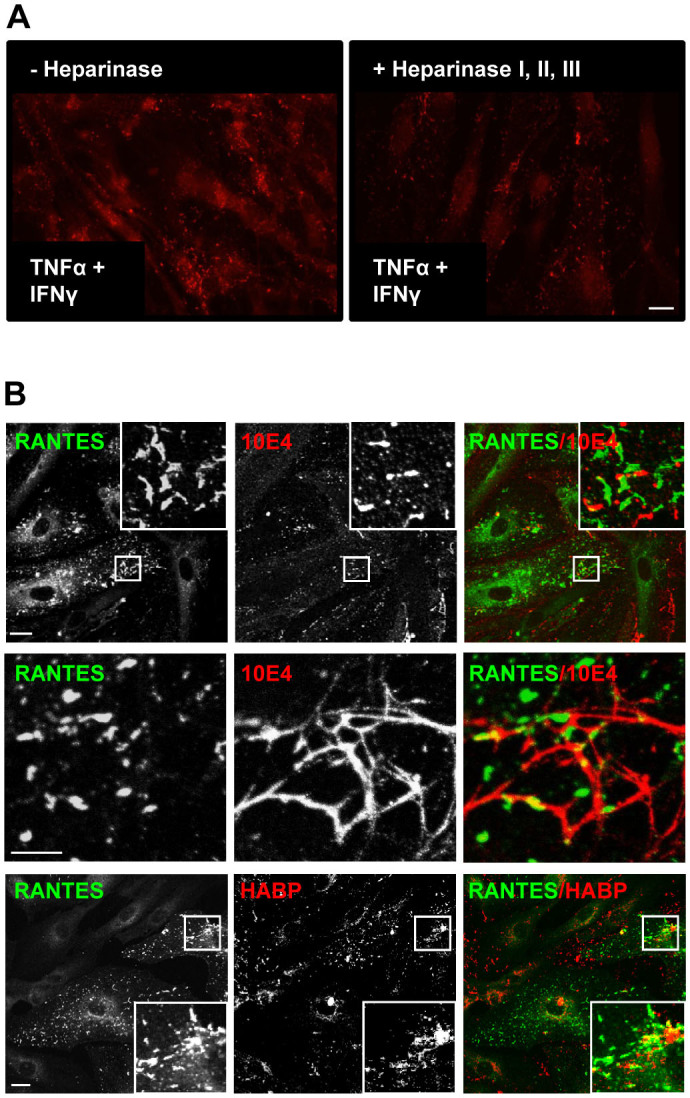
RANTES is immobilized to the cell surface via heparan sulfate.(A) HUVECs were stimulated for 48 h with 10 ng/ml TNFα +
1 ng/ml IFNγ before half of the samples were incubated with a
mixture of heparinase I, II, and III (0.5 U/ml) for 2 h. Next,
the cells were fixed and immunolabelled with clone ID2/A12 and analyzed by
widefield microscopy. Scale bars, 50 μm. (B) HUVECs stimulated
with 10 ng/ml TNFα and 1 ng/ml IFNγ were immunostained
with antibodies towards RANTES (rabbit anti-RANTES antibody) and the heparan
sulfate epitope 10E4. Alternatively, biotinylated hyaluronan binding protein
(HABP) was used to label hyaluronan. The antibody towards 10E4 labelled
elongated structures in HUVECs (upper panel) and long structures at cell
borders or between cells (middle panel). Middle panel is a high
magnification from an original 100 × picture. Biotinylated HABP
labelled irregular clusters in HUVECs, and large, round structures between
cells (lower panel). The samples were analyzed following sequential scanning
confocal microscopy. Corner insets show high magnification of framed areas.
Scale bars, 10 μm.